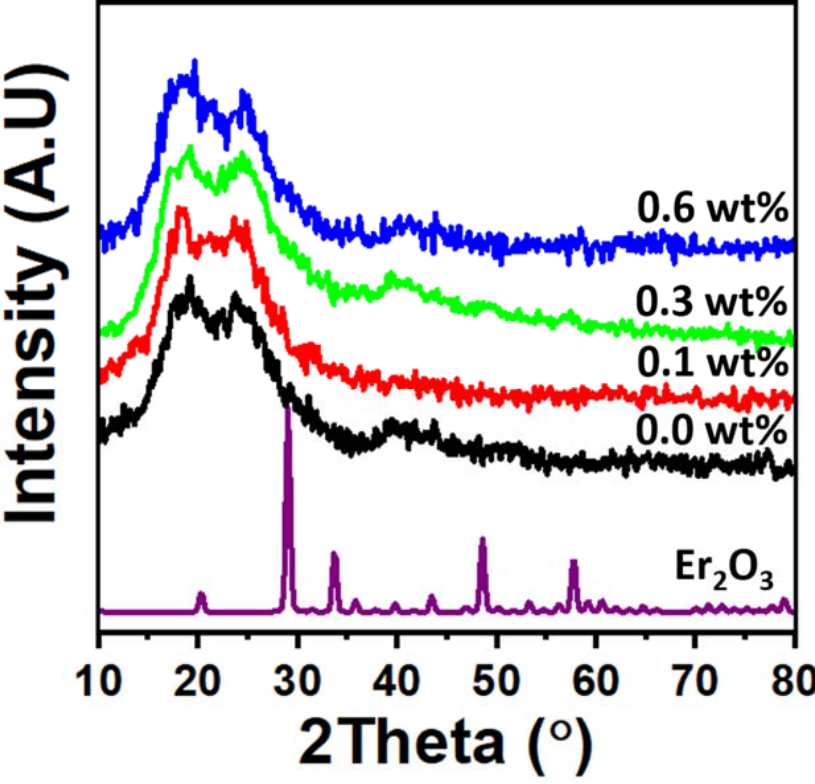
Figure 1. XRD diffraction peaks of PVC/PVP/Er 2 O 3 blend nanocomposites.